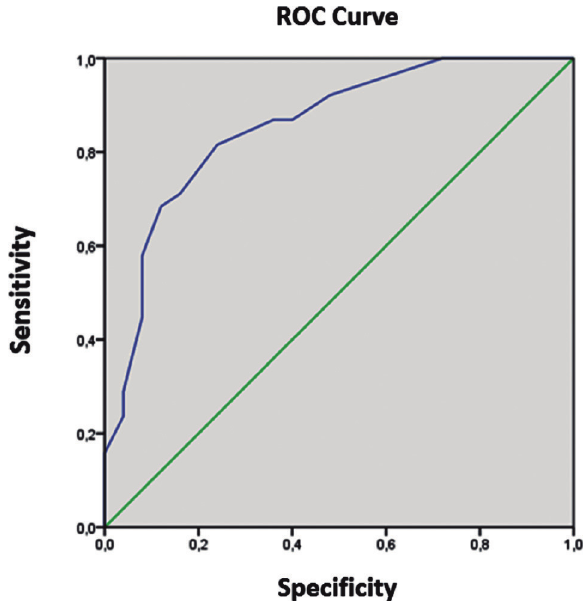
Figure 1. ROC curve determining cut-off score to distinguish Parkinson’s disease patients with normal cognition from patients with mild cognitive impairment using the MOCA-BR.